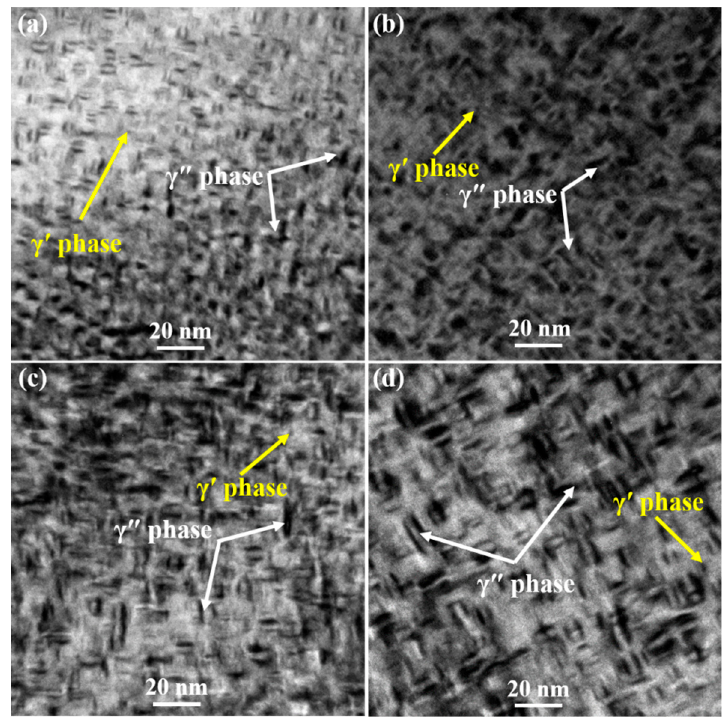
Figure 5. Morphologies of γ″ and γ′ phases. ( a ) Specimen A; ( b ) specimen B; ( c ) specimen C; ( d ) specimen D.